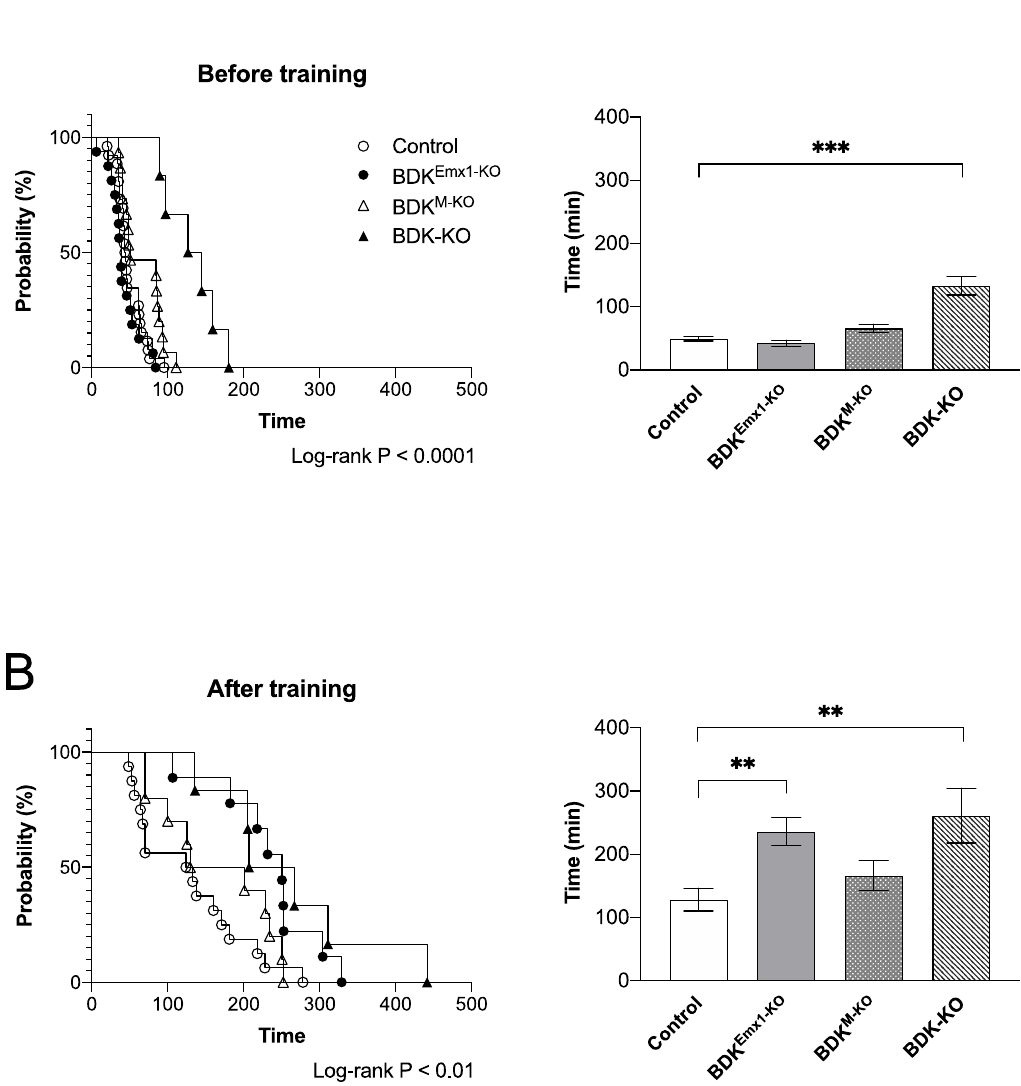
Figure 3. Endurance exercise performance in BDK Emx1-KO , BDK M-KO , and BDK-KO mice. Running time during endurance exercise of BDK Emx1-KO , BDK M-KO , and BDK-KO mice compared to control mice before ( A ) and after training ( B ). Values represent the mean ± SEM; before training, n = 26 for control, n = 16 for BDK Emx1-KO , n = 15 for BDK M-KO , and n = 6 for BDK-KO; after training, n = 16 for control, n = 9 for BDK Emx1-KO , n = 10 for BDK M-KO , and n = 6 for BDK-KO. ** p < 0.01 and *** p < 0.001 compared with control values. The di ff erence was determined using the log-rank (Mantel–Cox) test and Dunnett’s multiple comparisons test. BCAA: branched-chain amino acids; BDK: BCKDH kinase; KO: knock-out.